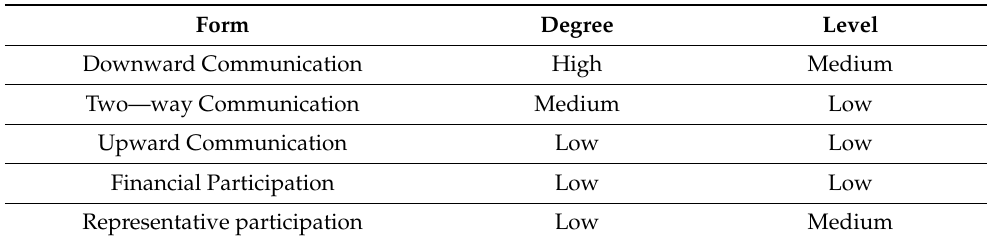
Table 13. Overall assessment of employee